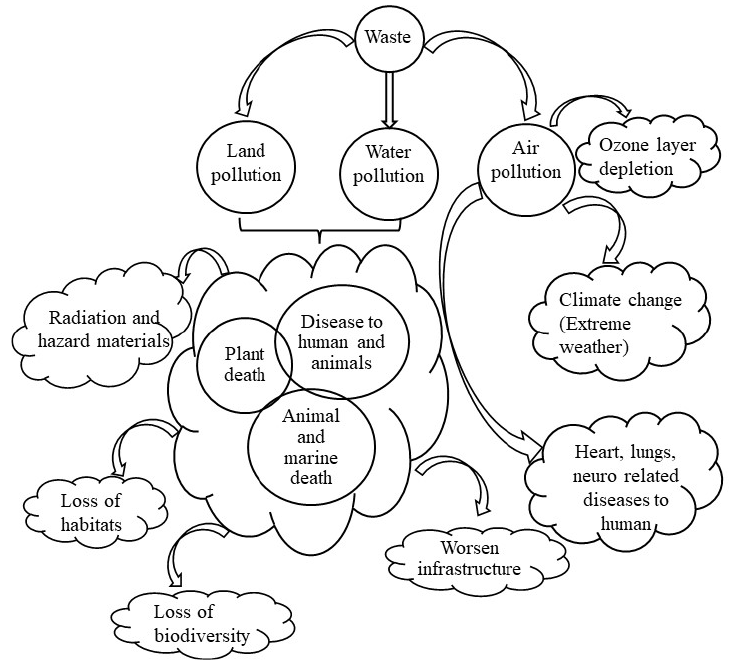
Figure 2. Adverse effect of waste on the environment and human health.